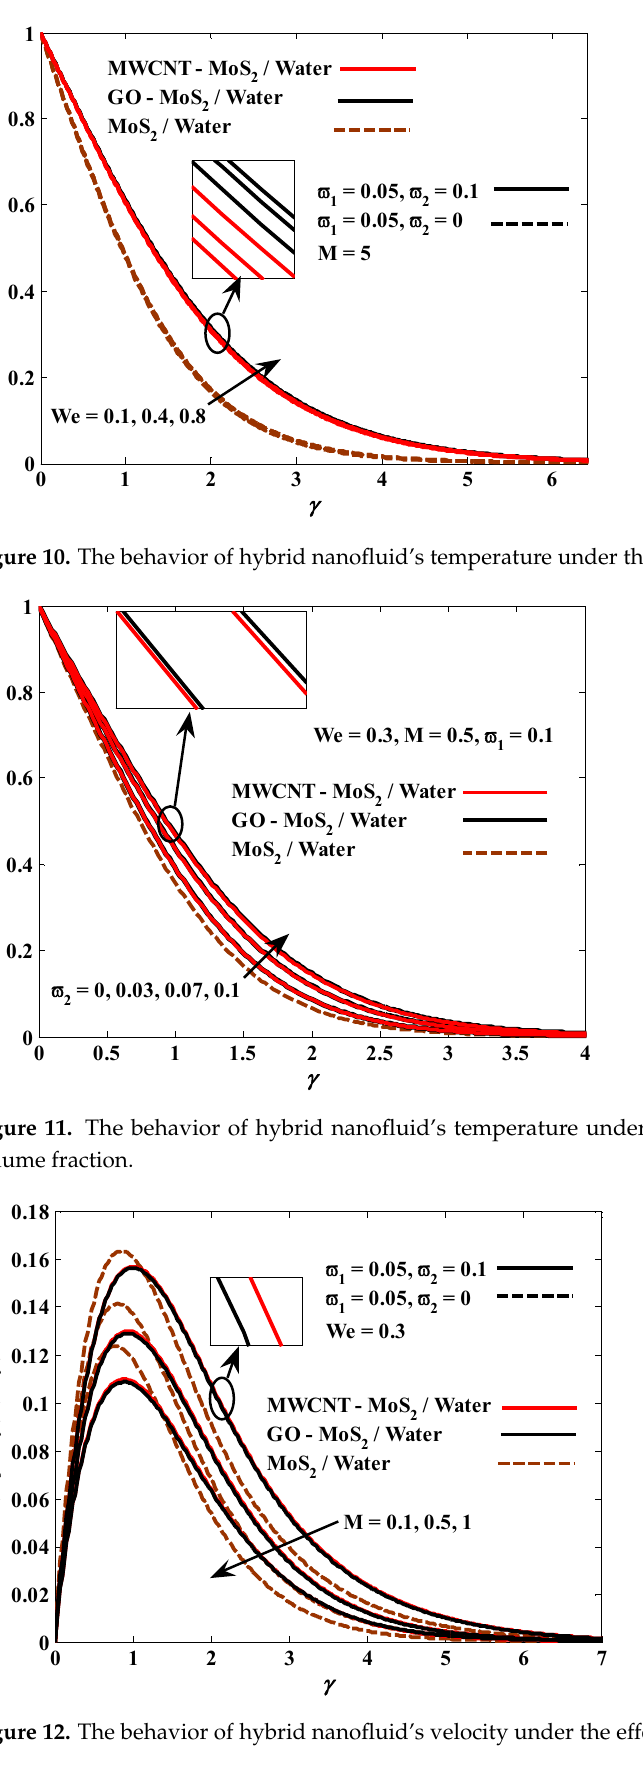
Figure 9. The behavior of hybrid nanofluid’s temperature under the effect of M.